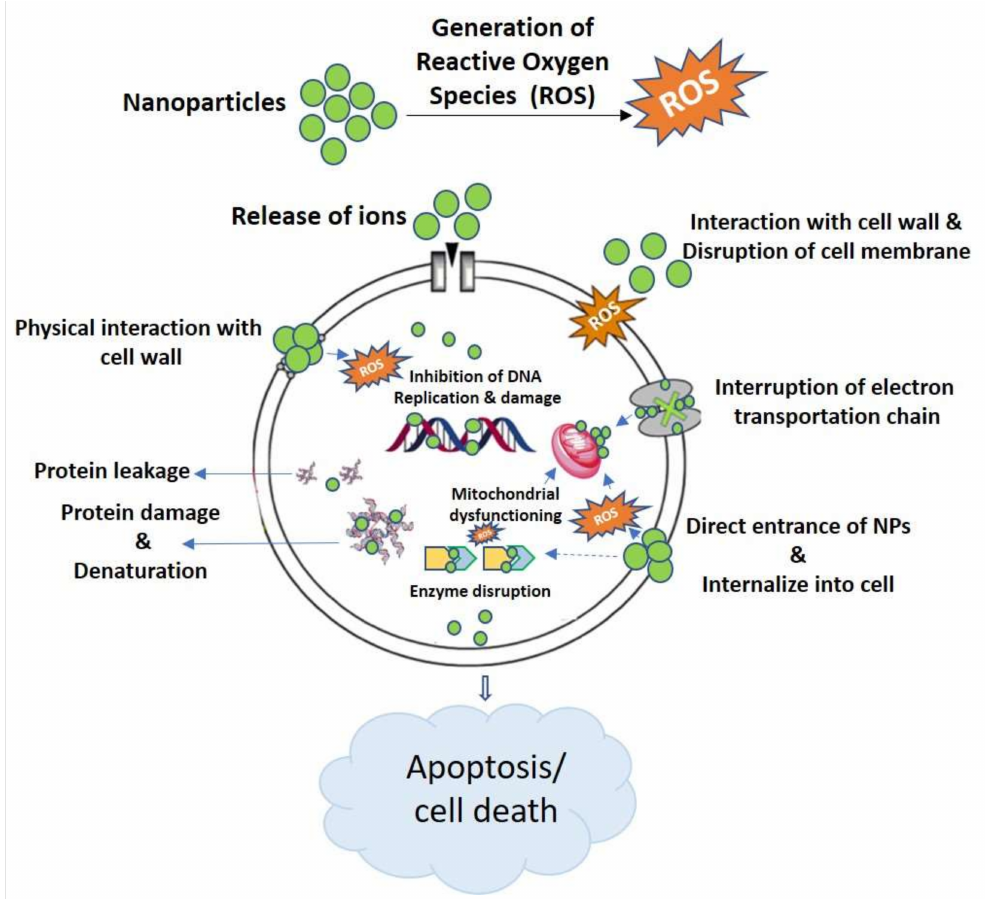
Figure 9. Possible antimicrobial mechanisms of